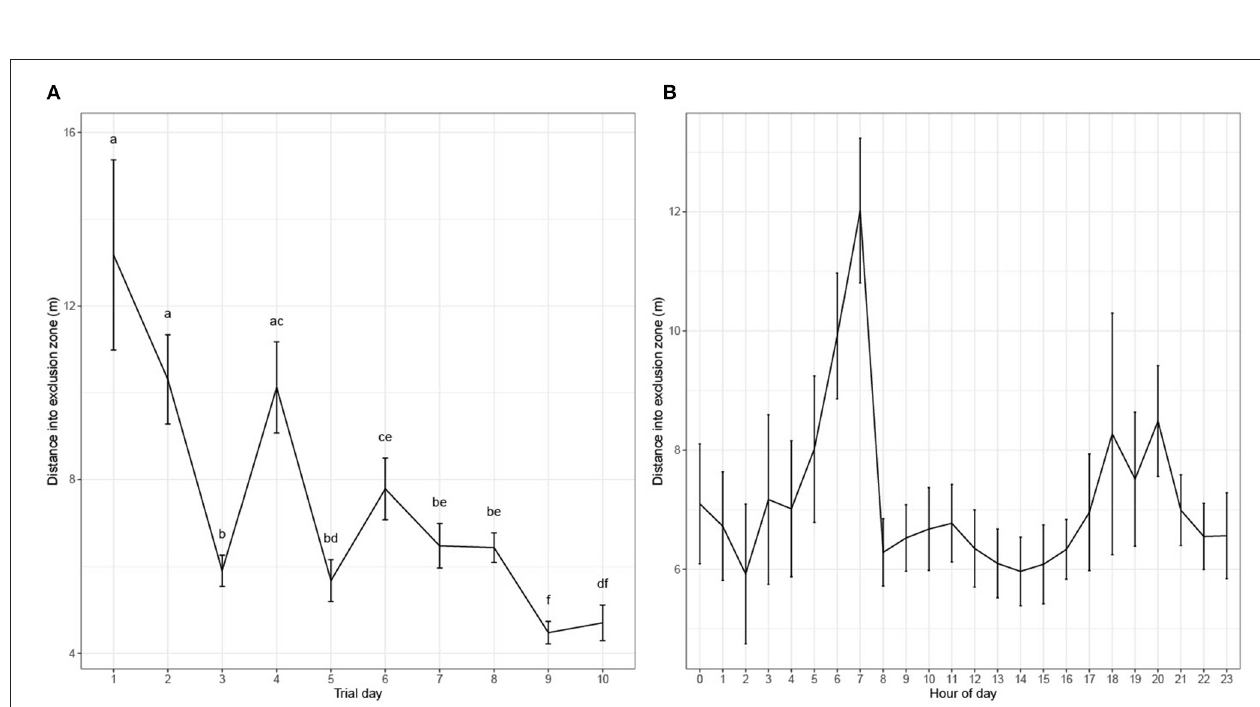
FIGURE 8 | (A) Model-based mean maximum distance (m) cows entered into the exclusion zone by day (1–10). Differences in superscripts a,b,c,d,e,f denotes significant difference between days P < 0.05. (B) Model-based mean maximum distance (m) entered into the exclusion zone by hour of all days (1–10).